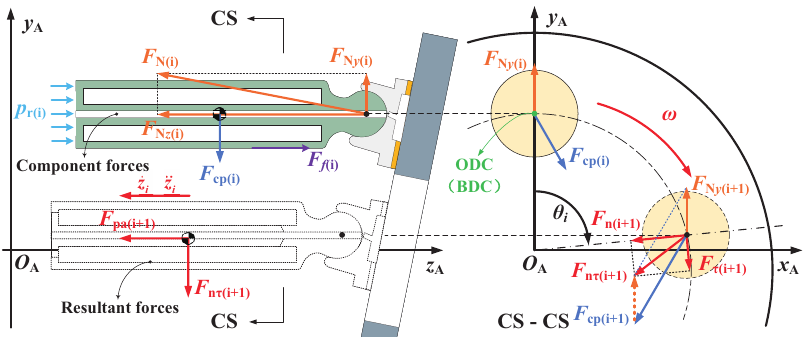
Figure 7. Forces on the piston-slipper